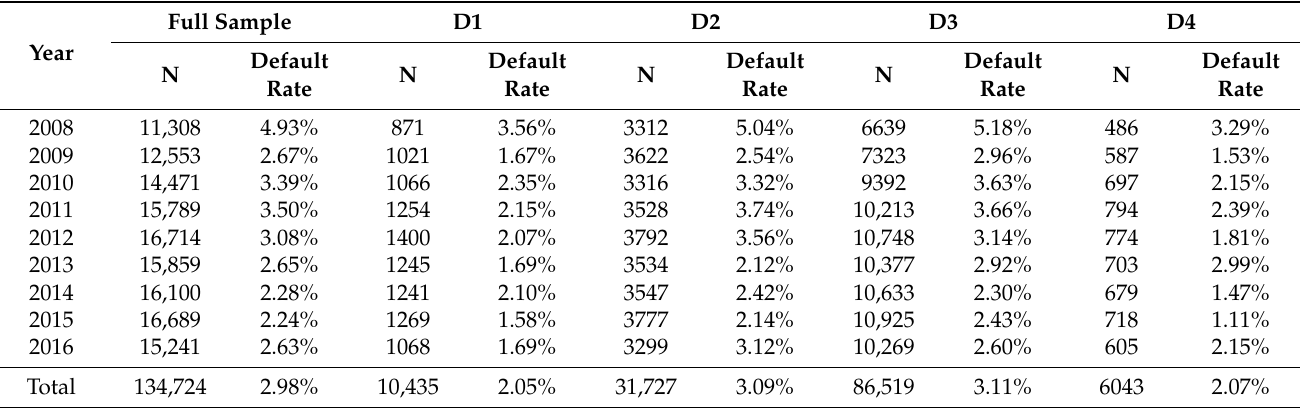
Table 2. Sample distribution by year.